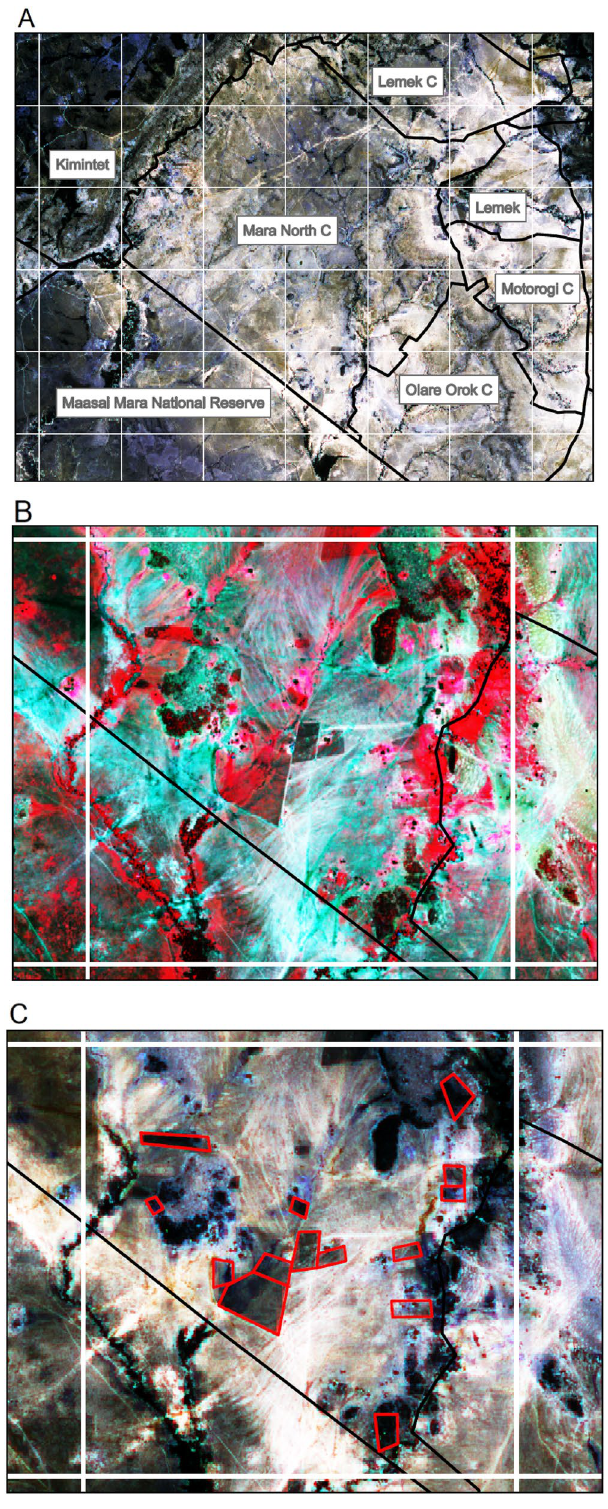
Figure 8. Method illustrated. White lines are the 4.5 × 4.5 km grid; black lines are the regional borders within the Greater Mara; red lines are digitalized fences based on a Sentinel-2 satellite image. ( A ) Mara North seen on Sentinel-2, with normal colors (bands: 4, 3, and 2). ( B ) One grid cell within Mara North (bold white square on Fig. 4A) based on near infrared, red and green, which makes fenced plots stand out as bright red. ( C ) The digitized fences. Based on ArcMap (vs.